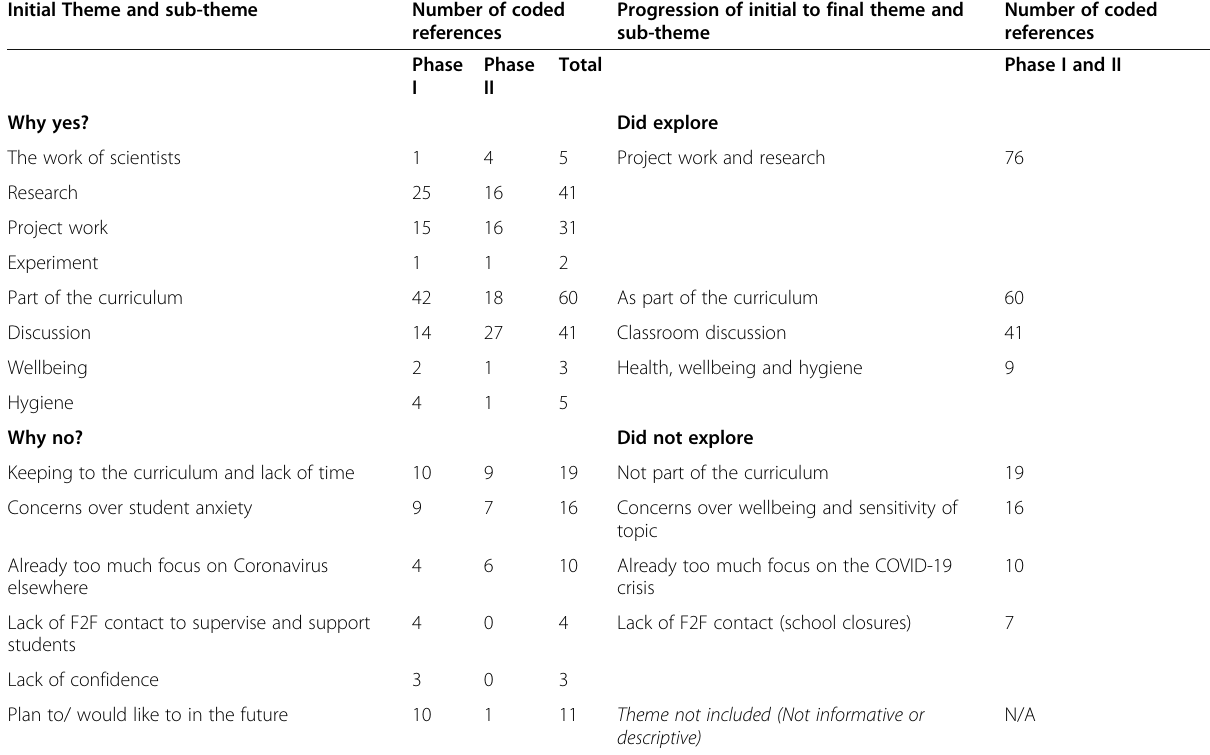
Table 1 Progression of initial themes to final themes from Phase I and II surveys Initial Theme and